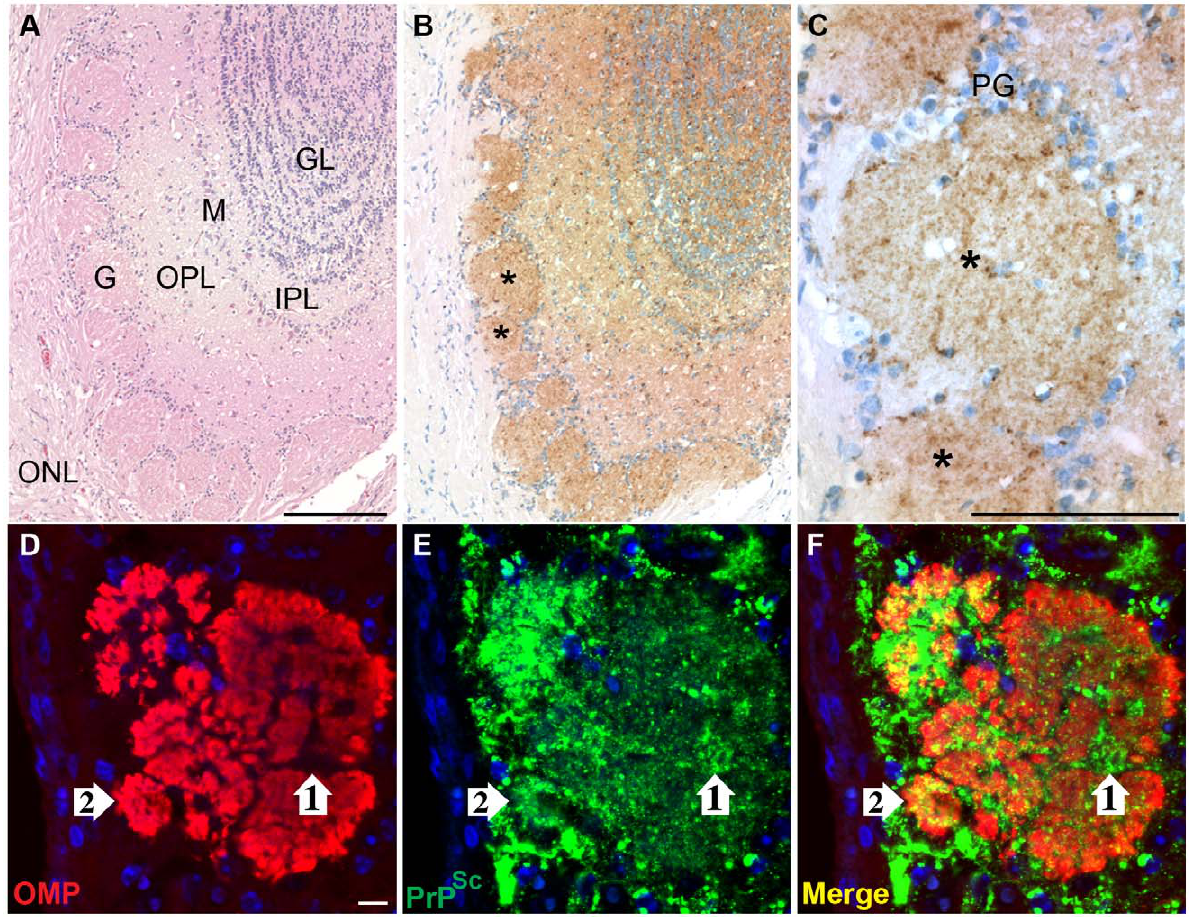
Figure 3. Distribution of PrP Sc in main olfactory bulb following HY TME infection. Hematoxylin and eosin staining of olfactory bulb ( A ) and PrP Sc immunohistochemistry ( B , brown chromagen and hematoxylin counterstain of nuclei) in adjacent tissue section revealed a strong PrP Sc pattern throughout the olfactory bulb including the granule layer (GL), inner plexiform layer (IPL), mitral cell layer (M), outer plexiform layer (OPL), and glomeruli (G), but not in the outer nerve layer (ONL). Asteriks in panel B illustrate PrP Sc deposition in a single glomerulus, which is enlarged in panel C (PG=periglomerular cells). In D to F , double immunofluorescence and laser scanning confocal microscopy was used to demonstrate the relationship of olfactory marker protein (OMP)( D ) and PrP Sc ( E ) in a single glomerulus of the olfactory bulb. OMP and PrP Sc immunofluorescence are merged in panel F and nuclei were stained with ToPro-3 (blue). White arrow # 1 illustrates PrP Sc immunofluorescence that was surrounded by OMP immunofluorescence in the glomerulus, while white arrow # 2 is an example of PrP Sc and OMP overlap in the glomerulus. Immunofluorescence staining and LSCM were performed as described in materials and methods. Scale bar is 100 m m in A and C and 10 m m in D .